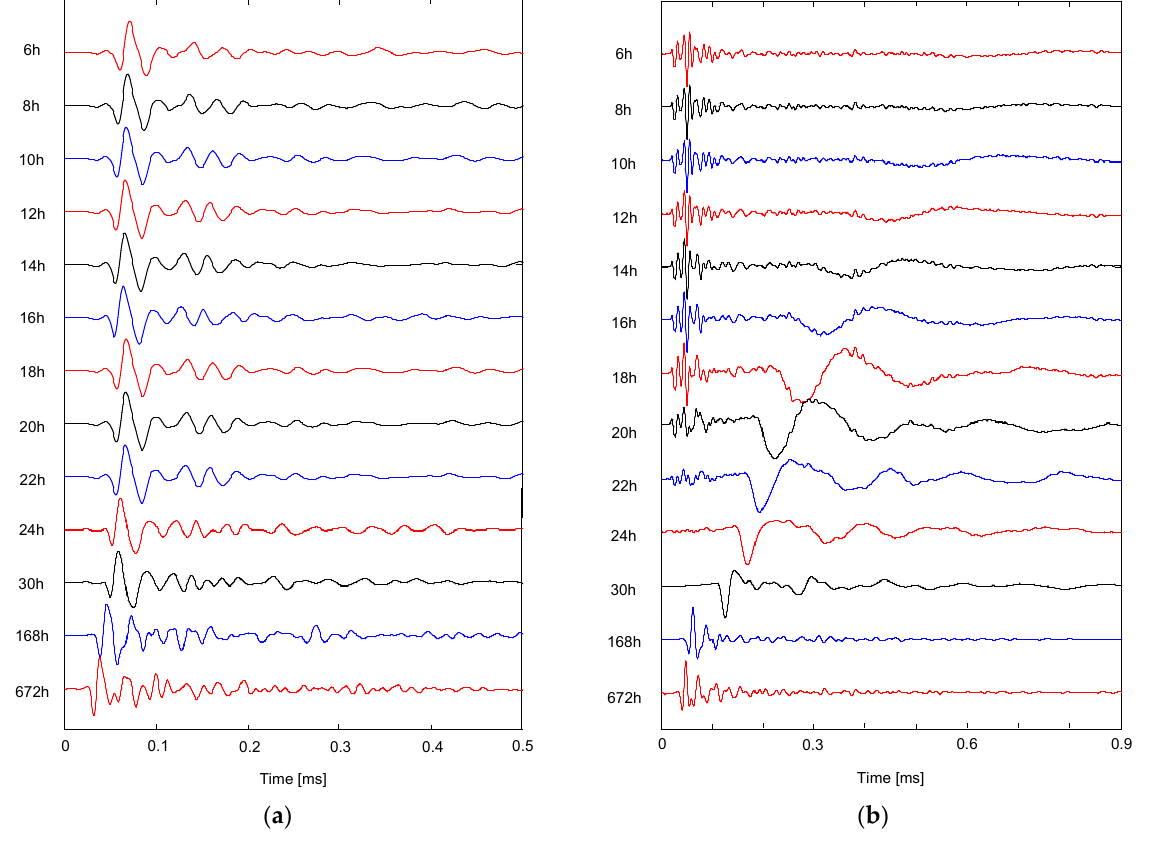
Figure 7. Typical signals obtained from the specimens of ( a ) M3 and ( b ) M6. SWV is determined by dividing the travel distance of shear wave by its first arrival time. In this study, tip-to-tip distance between two bender elements was selected as the travel distance. The SWV along the curing time is plotted in Figure 8. At the curing time of 10 h, SWVs for M1–M3 were greater than those for M4–M6. After 20 h, SWVs for M4–M6 rapidly increased with the curing time. Notably, the initial setting times for M4–M6 ranged from 20.6 to 27.6 h, and the differences between the initial and final setting times for M4–M6 were shorter than those for M1–M3. After the curing time of 3 days, the increasing rates of SWVs for M2–M6 were similar. For M1, the SWV significantly increased after 3-days curing, which concurred with the findings on the elastic modulus obtained from UCTs.